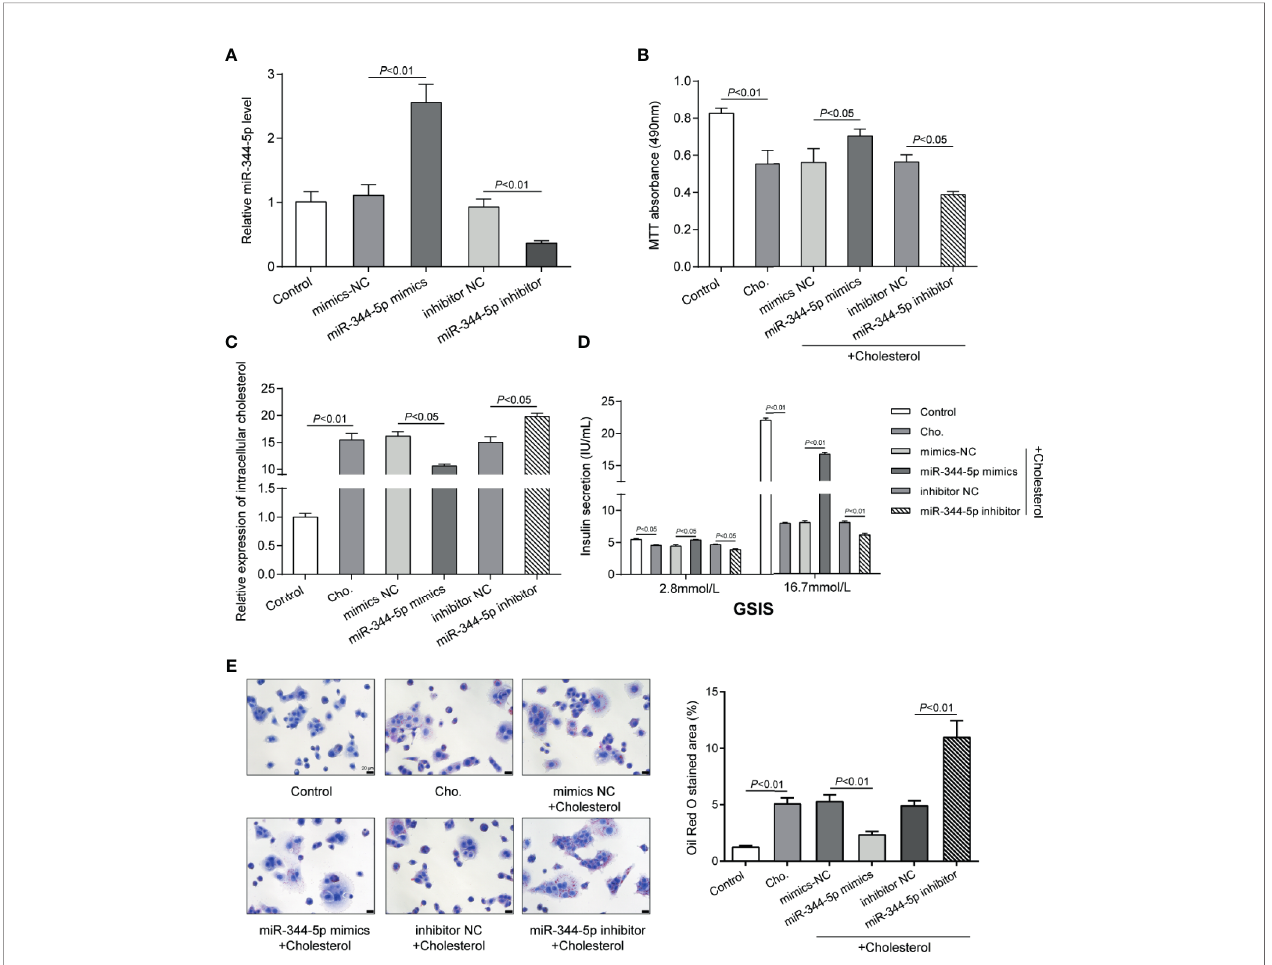
FIGURE 2 | Effects of miR-344-5p on cholesterol-induced b -cell dysfunction. (A) miR-344-5p overexpression or inhibition was achieved in INS-1 cells by transfecting miR-344-5p mimic or inhibitor. The transfection ef fi ciency was veri fi ed using real-time PCR 48 h after transfection. Then, pancreatic b -cell line, INS-1, was transfected with miR-344-5p mimic or inhibitor for 48 h, treated with 5 mM cholesterol for 12 h, and examined for cell viability by MTT assay (B) ; intracellular cholesterol levels by cholesterol assay kits (C) ; glucose-stimulated insulin secretion (GSIS) by an insulin ELISA kit (D) ; the fat droplets deposition by Oil Red O staining (E)